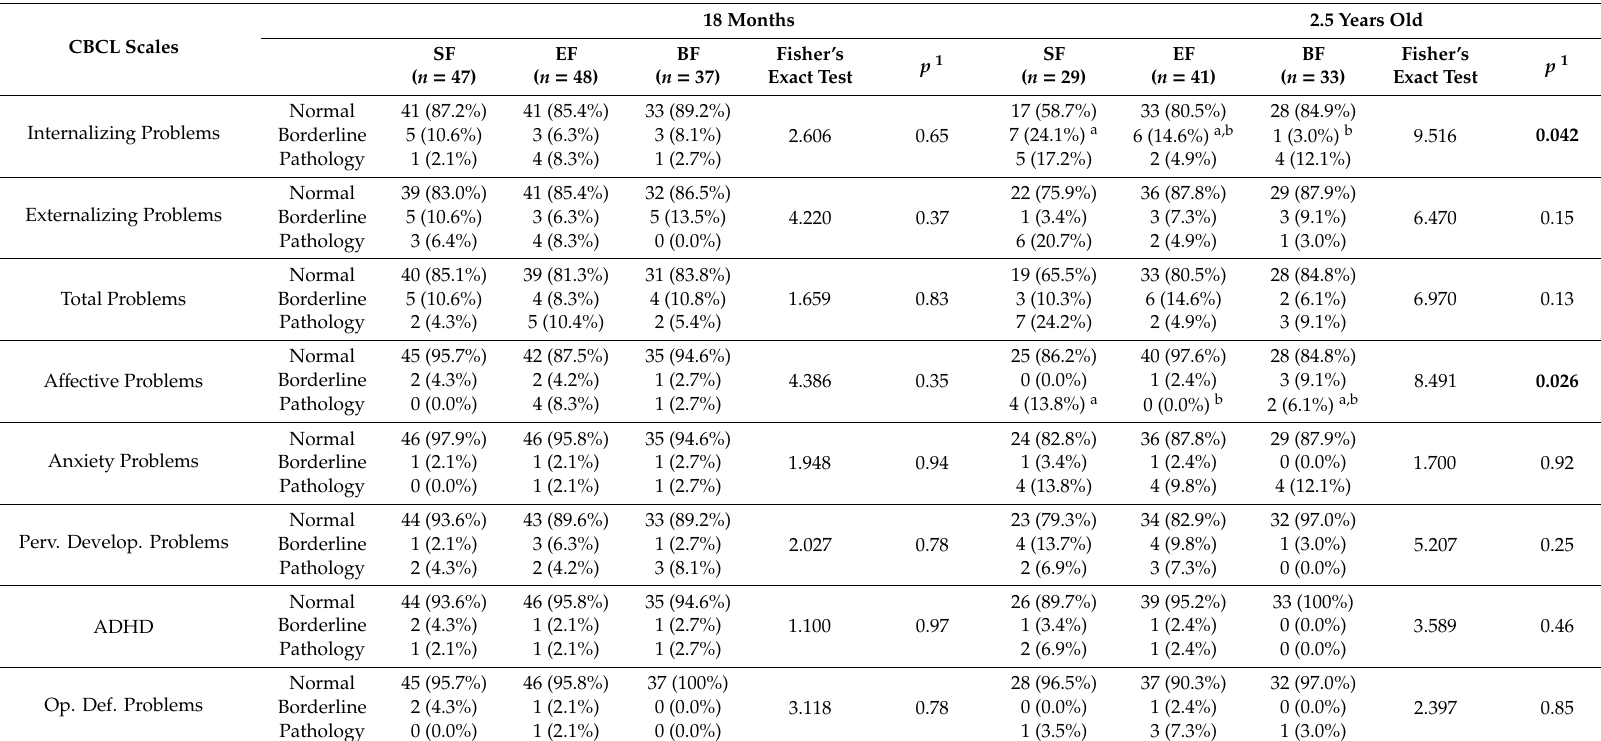
Table 2. Association between early nutrition and CBCL clinical clusters problems in children at 18 months and 2.5 years